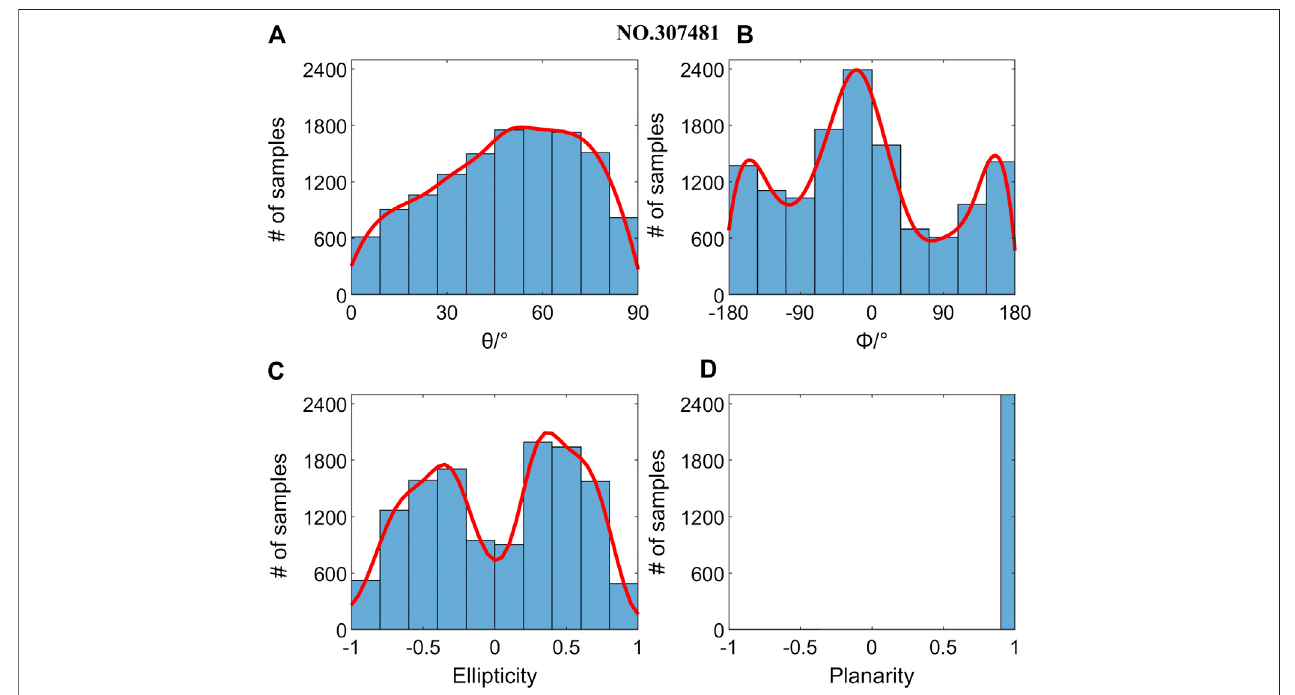
FIGURE 10 | Distribution of wave propagation parameters for the waves at extremely low frequency (300 – 800 Hz) in the area (1.95 ° S – 6.89 ° N, 99.29 ° − 97.44 ° E) at 15:08 to 15:10 UT recorded by No. 307481 on March 31, 2010. The overlapped red lines represent fi tted curves computed by a probability density function; (A) wave normal angle θ ; (B) and azimuth angle ϕ of the wave vector; (C) the ellipticity; (D)